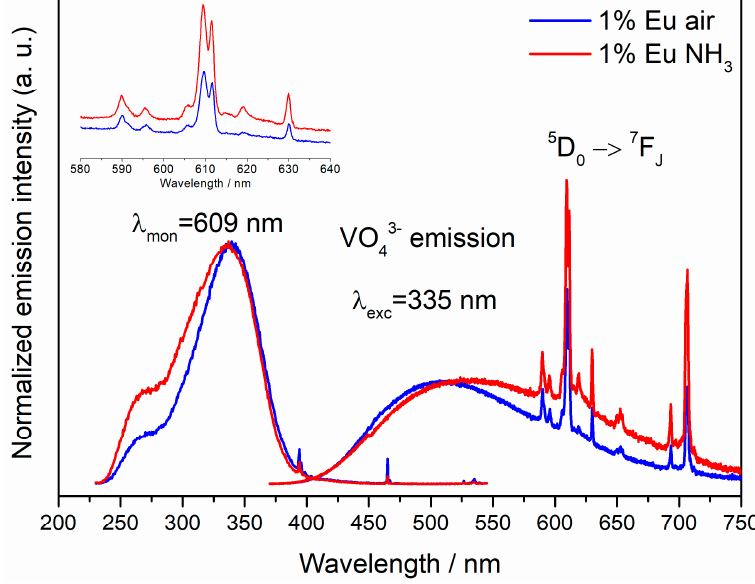
Figure 4. Luminescence spectra excited at 330 nm and luminescence excitation spectra monitoring the emission at 609 nm of Ca 2 NaMg 2 V 3 O 12 : Eu (1%) obtained in the air (red traces) and NH 3 (blue traces).